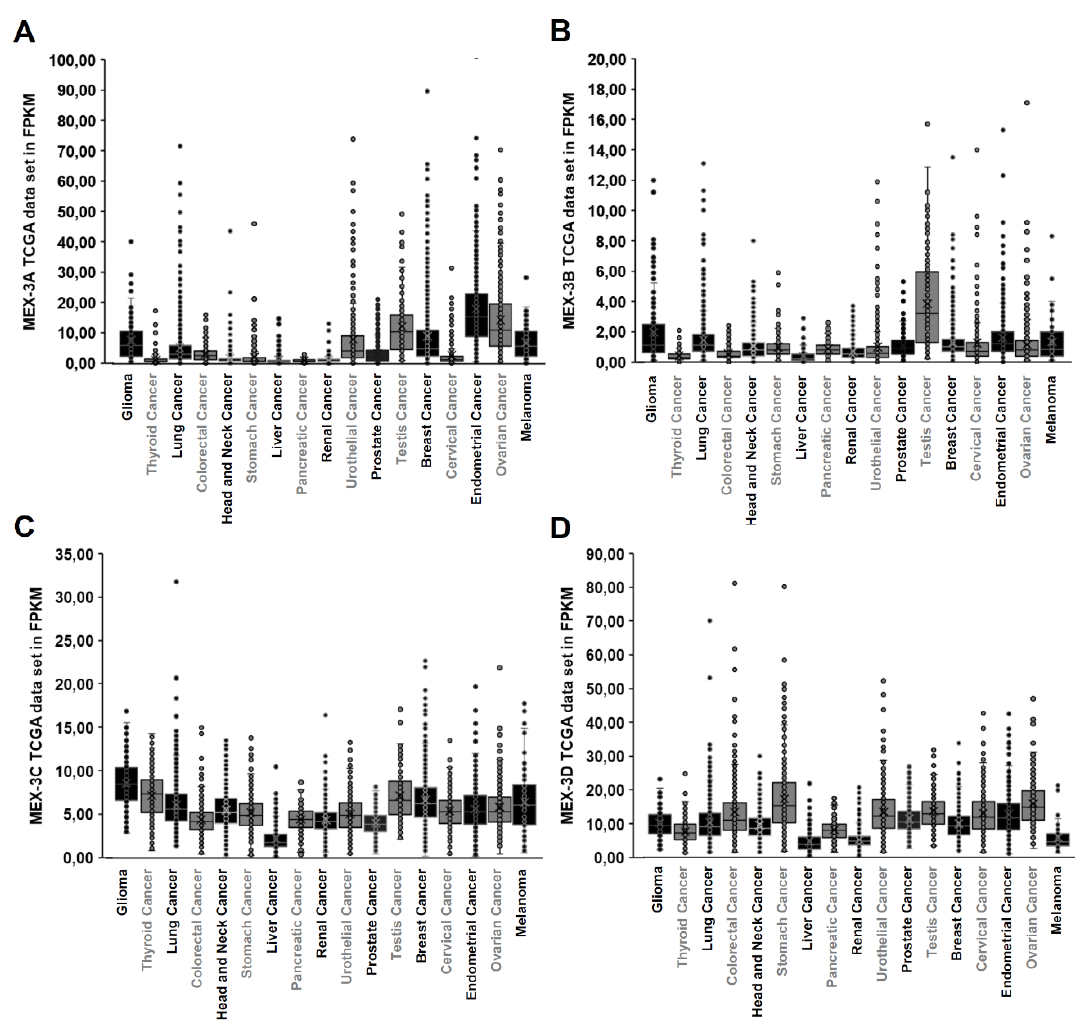
Figure 2. TCGA data sets for MEX-3A-D gene expression in selected human cancers. ( A – D ): TCGA expression data for MEX-3A-D in 17 different tumor entities expressed as median FPKM (number fragments per kilobase of exon per million reads) generated by The Human Protein Atlas [20–22].